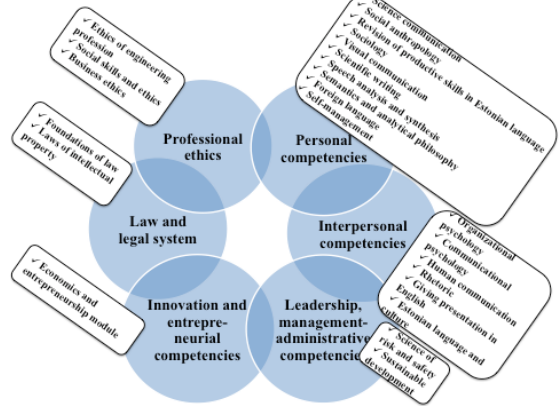
Figure 1. The Model of Non-technical Engineering Competences: Subjects that Develop Non-technical Engineering Competences